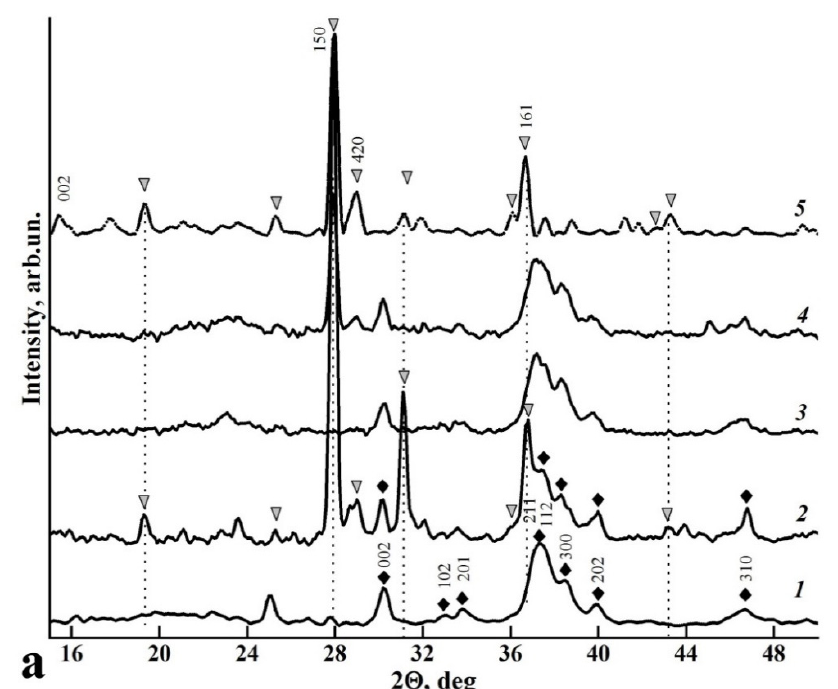
Figure 2. XRD scans of the biocomposite samples: ( a ) n-cHAp (curve 1); n-cHAp/L-LysHCl biocomposites obtained from solutions of pH ≤ 5 (curve 2), pH ≥ 7.5 (curve 3) and pH ≥ 11.2 (curve 4); L-LysHCl amino acid sample obtained by crystallisation from solution with pH ≥ 11.2 (curve 5). ( b ) n-cHAp (curve 1); n-cHAp/L-ArgHCl biocomposites obtained from solutions with pH < 5 (curve 2), pH ≥ 7.5 (curve 3), and pH ≥ 11.2 (curve 4); L-ArgHCl amino acid sample obtained by crystallisation from a solution with pH ≥ 11.2 (curve 5). ▼ —diffraction reflexes of L-LysHCl, ♦ —diffraction reflexes of n-cHAp.